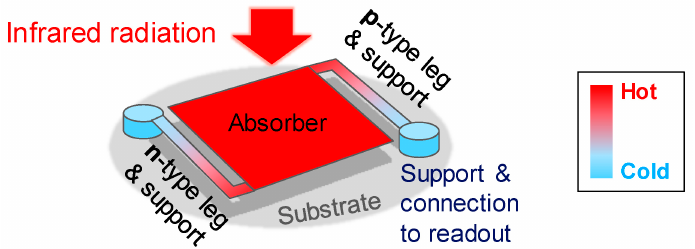
Figure 1. A schematic of a thermoelectric bolometer: (i) The absorber absorbs the incident thermal radiation. (ii) The thermoelectric transducer consisting of n- and p-type legs converts the thermal signal to voltage and passes it to the readout electronics. (iii) The supporting beams support the structure and provide thermal isolation. The thermoelectric transducer can be located on/in the supporting beams or it itself can act as support as in the present nanomembrane